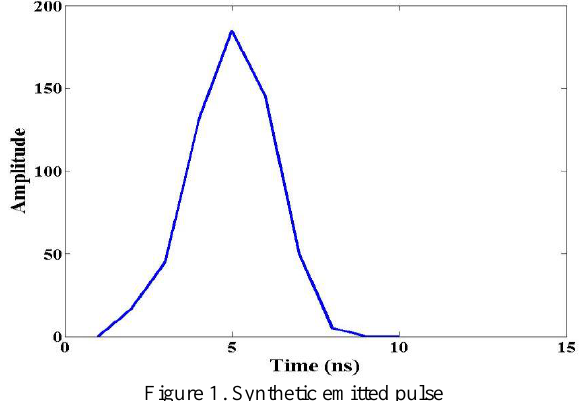
Figure 1. Synthetic emitted pulse